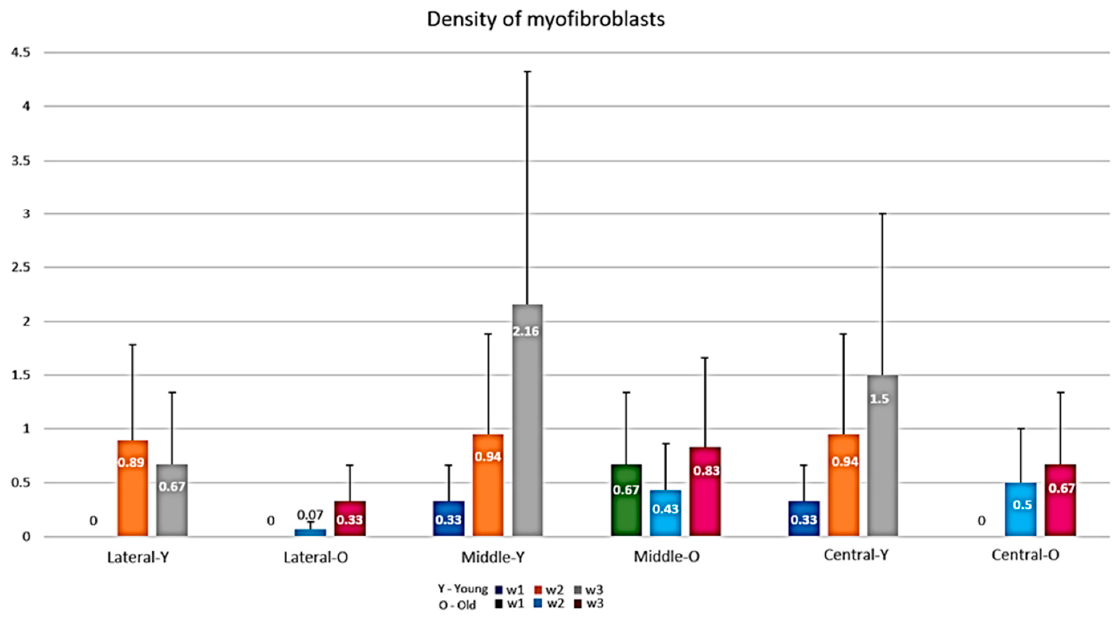
Figure 7. Representative photomicrographs of inflammation and myofibroblasts in young and old rats, weeks 1–3 (origi- nal magnification of all microscopic sections ×40). Scale bar 500µm. Hematoxylin and eosin stain (H&E), Alpha Smooth Muscle Actin ( α -SMA). 4. Discussion Despite existing studies using experimental palatal wounds as a model, age-related data regarding the dynamics of the healing process at the wound site remain incomplete. The novel approach of the present study lies in investigating the age-related macroscopic pattern of secondary intention mucoperiosteal wound healing outcome in the A-P vs. the L-L planes. A significant decrease was found for the A-P vs. an insignificant decrease in the L-L dimension along time in the young rats, only during the first week. A significant decrease was found for both A-P and L-L dimensions along time in the older rats. No dimensional changes were noted during the first week in the young rats vs. significant in the old rats. It can be speculated that the increased inflammatory reaction (more specifically, increased inflammatory and stem cell numbers) demonstrated in the young rats, especially in the first week, is responsible for the increased distance in each time frame as a result of addi- tional wound damage caused by the amplified inflammatory reaction. The macroscopic healing (Figure 8) at W1 was minimal in the young rats, as shown previously [13,23], and significant in the old rats. As stated previously, the increased in- flammatory reaction in young rats may be responsible. From W1, during the proliferative phase in both groups the defect gradually filled with soft tissue. The changes were statis- tically significant and more prominent in the old rats. The myofibroblastic score demon- strated no statistically significant differences between the young and the old rats. These